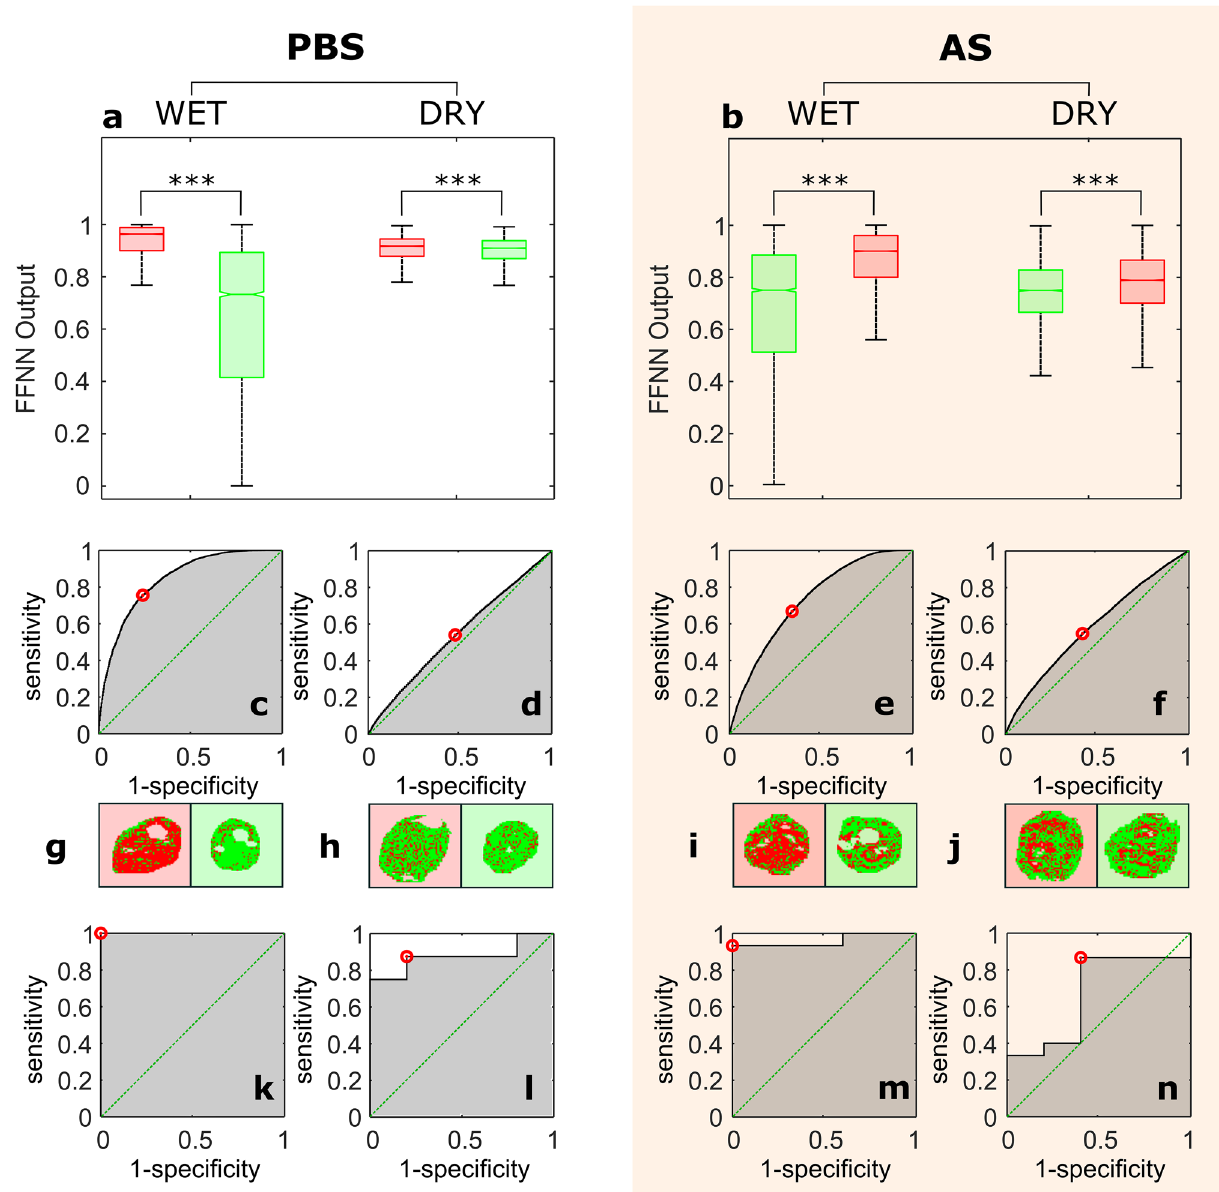
Figure 4. Classification of VSV-G pseudotyped lentiviral particles using FFNN. ( a ) median value of the FFNN output used for pixel classification for samples prepared in PBS. ( b ) median value of the FFNN output used for pixel classification for samples prepared in AS. ( a,b) the boxes represent the interquartile range, and the whiskers show 2.7 times the standard deviation. Lentiviral particles (LP), denoted here in red, were prepared in PBS (LP-PBS) or in artificial saliva (LP-AS). Negative controls, represented here in green, were prepared from non-transfected culture media in PBS (PBS-control) or in artificial saliva (AS-control). *** p-value < 0.0001 from two-tailed Wilcoxon rank-sum test. ( c ) ROC curve obtained from the pixel classification of LP-PBS. ( d) ROC curve from the pixel classification of LP-PBS obtained after complete evaporation of the water content. ( e) ROC curve obtained from the pixel classification of LP-AS. ( f ) ROC curve from the pixel classification of LP-AS obtained after complete evaporation of the water content. ( g–j) example of a pixel classification in a droplet. Red and green pixels denote pixels classified as positive and negative respectively. Note red and green backgrounds indicate positive droplet and its negative control respectively. ( g ) LP-PBS. ( h ) LP-PBS dry residue. ( i) LP-AS. ( j) LP-AS dry residue. ( k) ROC curve obtained from droplet classification of LP-PBS. ( l) ROC curve from droplet classification of LP-PBS obtained after complete evaporation of the water content. ( m) ROC curve obtained from droplet classification of LP-AS. ( n) ROC curve from droplet classification of LP-AS obtained after complete evaporation of the water